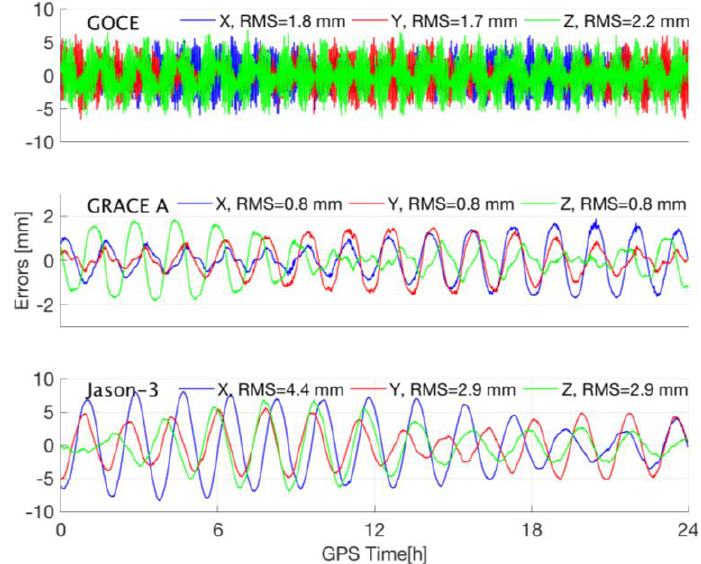
Figure 2. The computed low-Earth orbit (LEO) satellite STP errors, with one-day precise reduced dynamic orbit products as the “true” value , with different sampling intervals: GOCE and GRACE (30-s intervals), and Jason-3 (60-s intervals).